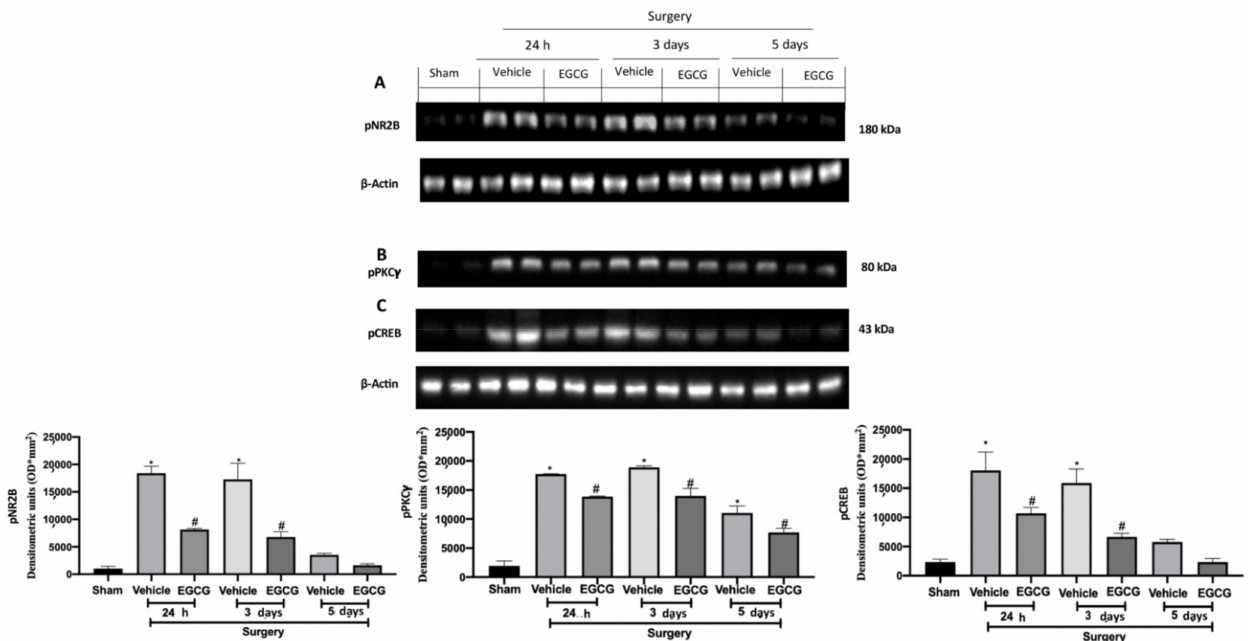
Figure 5. EGCG administration reduced pNR2B, pPKC γ and pCREB expression: Western blot analysis of: pNR2B ( A ), pPKC γ ( B ), pCREB ( C ) expression. A p -value of less than 0.05 was considered significant. * p < 0.05 vs. sham, # p < 0.05 vs.